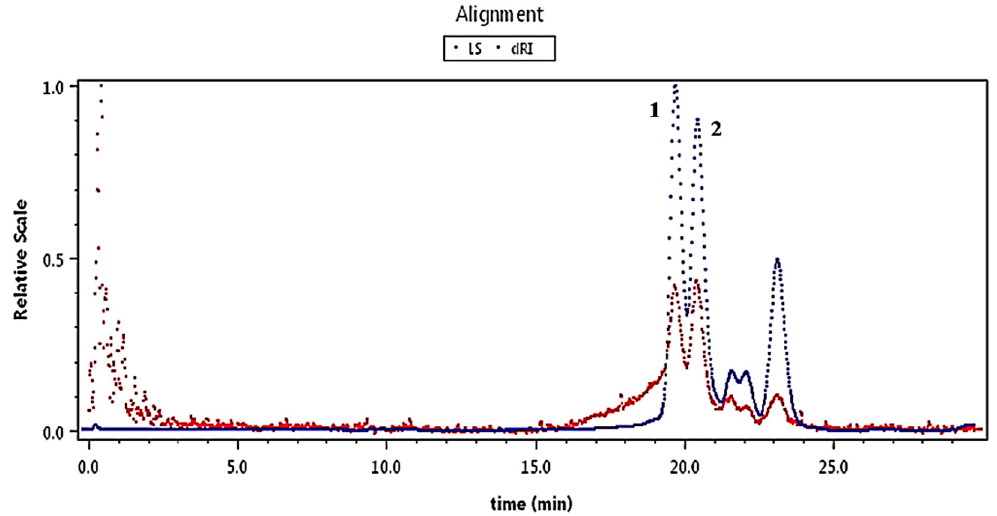
Figure 2. The analysis results of GPC.